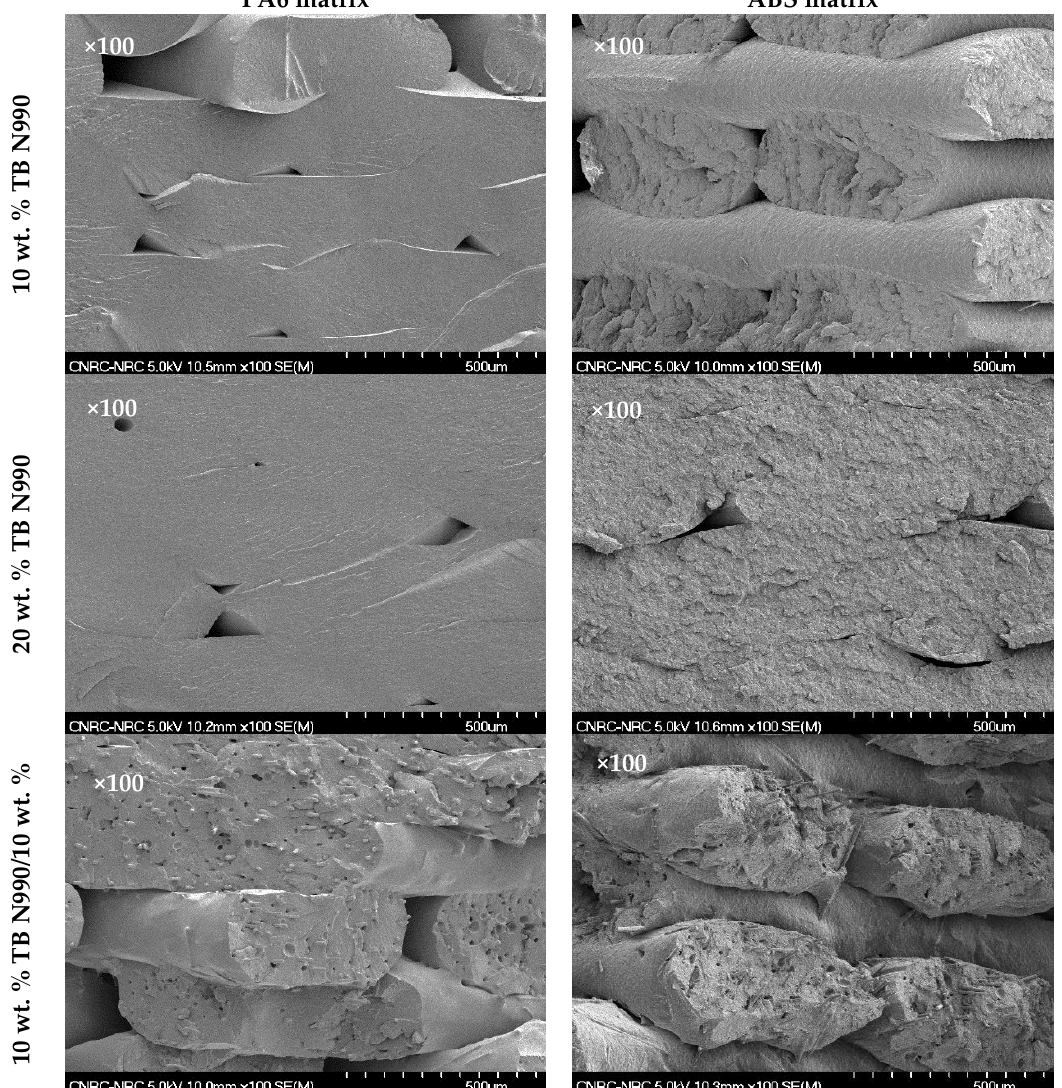
Figure 14. SEM morphology (x100) of 3D printed parts based on PA6 matrix (1st column) and ABS matrix (2nd column) and containing 10 wt. % TB N990 (1st row), 20 wt. % TB N990 (2nd row) and 10 wt. % TB N990/10 wt. % CF (3rd row).